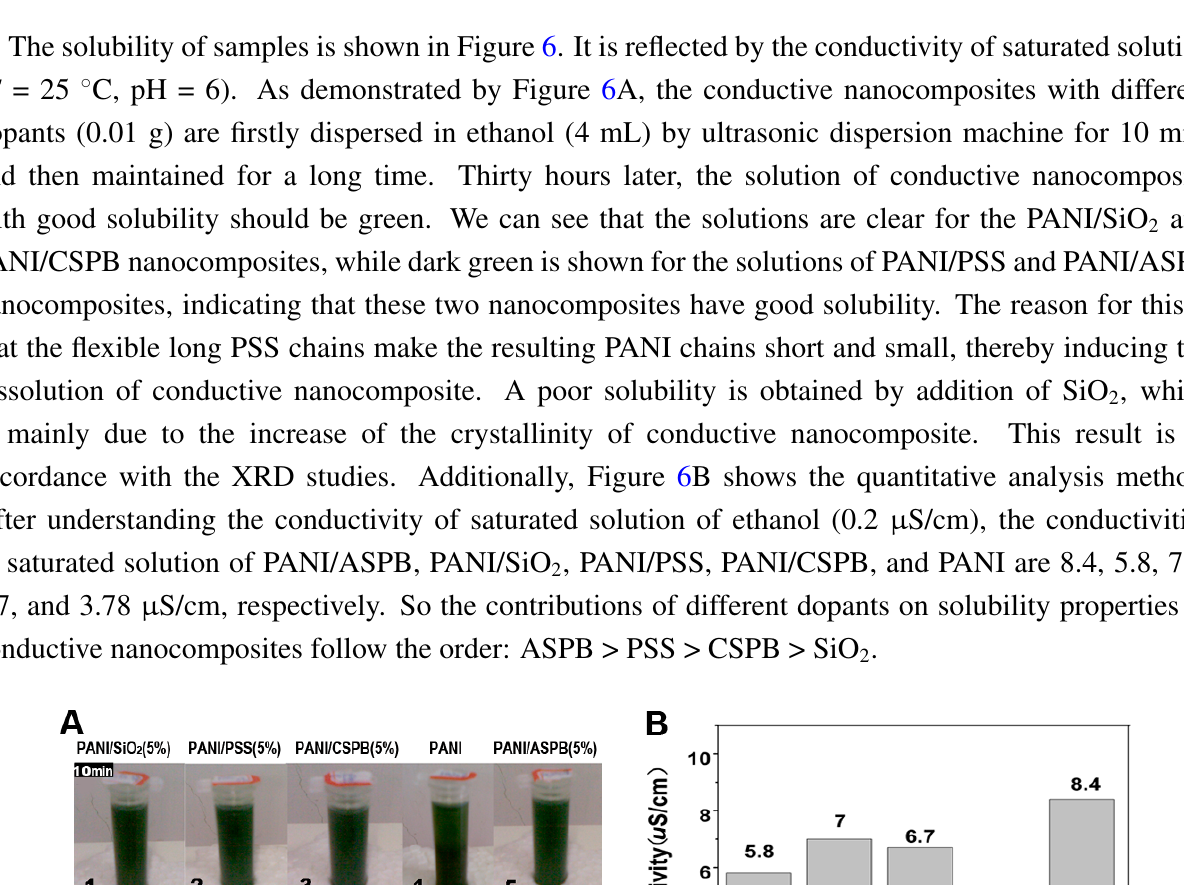
nanocomposites 2